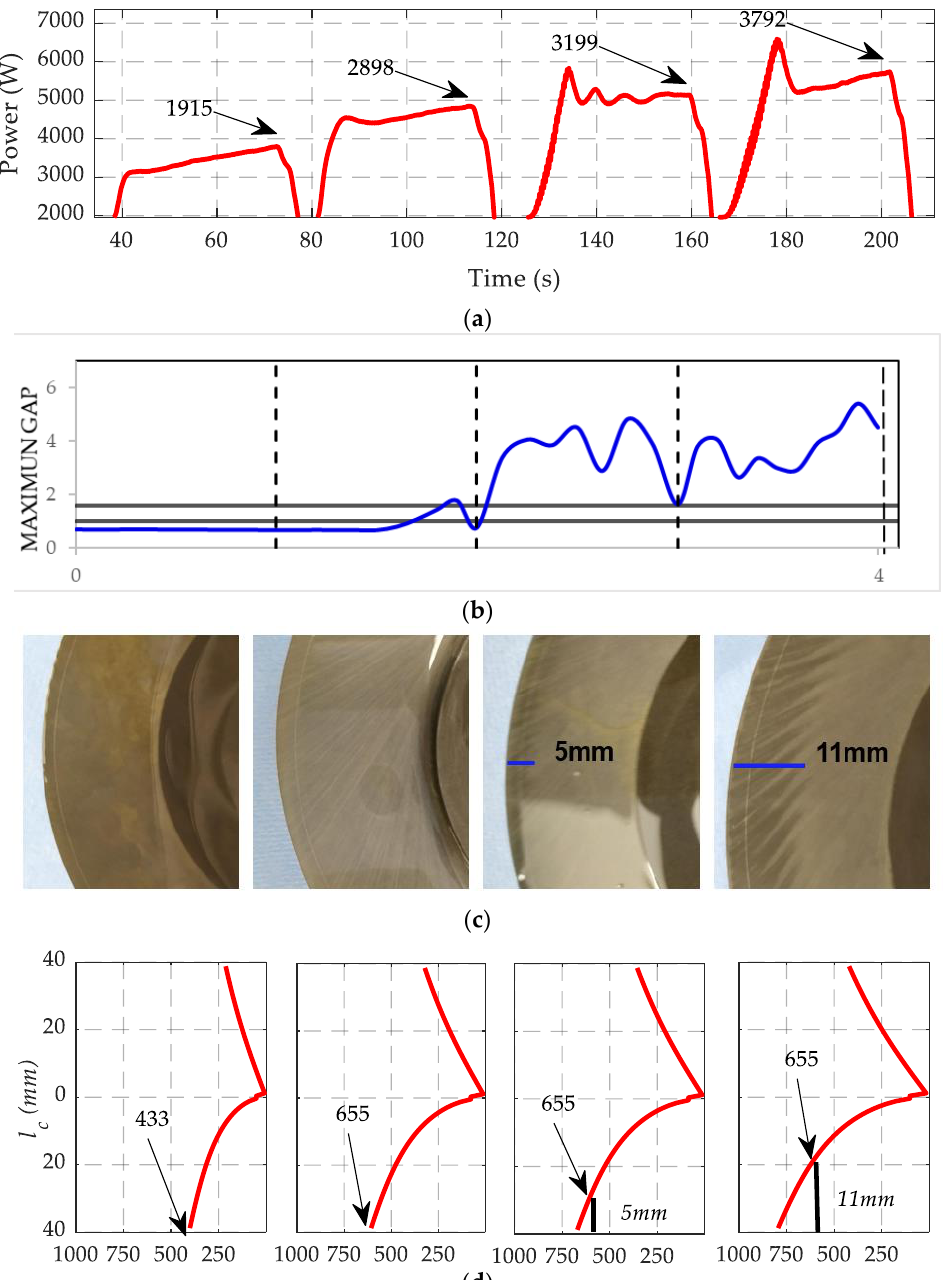
Figure 9. ( a ) Experimental power measurement in the four grinding passes; ( b ) in-process eddy current signal measurement; ( c ) acid etching post-process inspection; ( d ) surface temperature simulation in the face ( ε = 0.5).